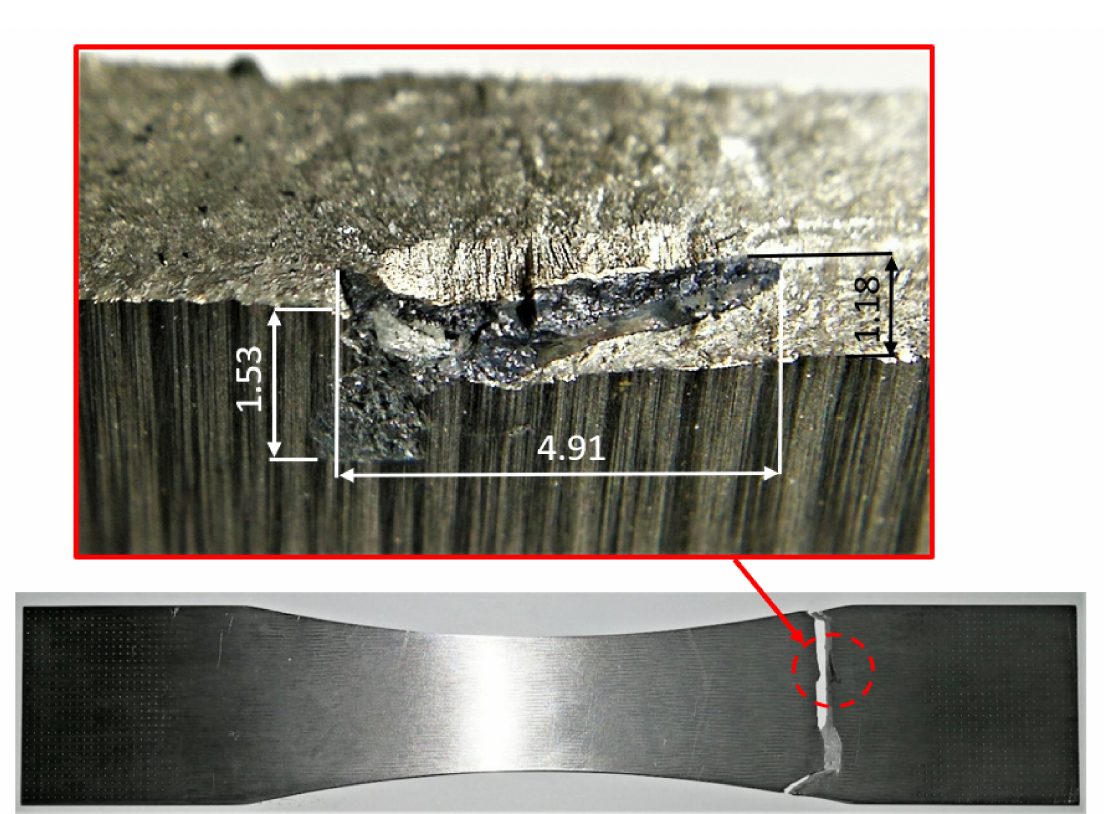
Figure 4. Expanded view of the failure and the near-surface